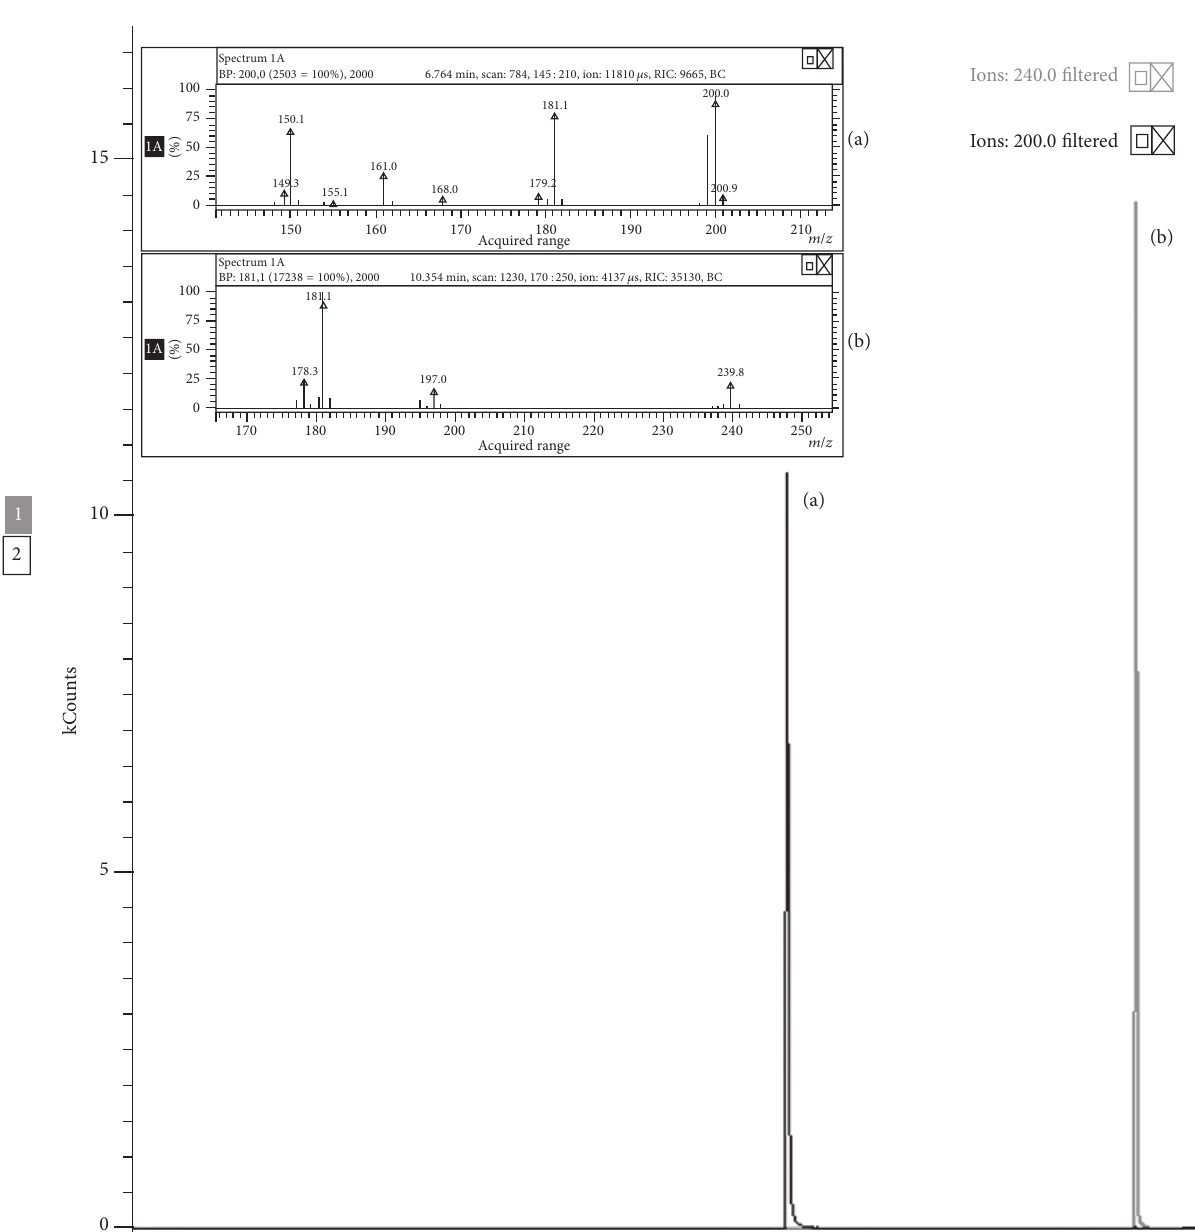
Figure 1: GC/MS chromatogram and EI mass spectrum of the (a) fluoride- and (b) acetate-2,3,4,5,6-pentafluorobenzyl bromide ester